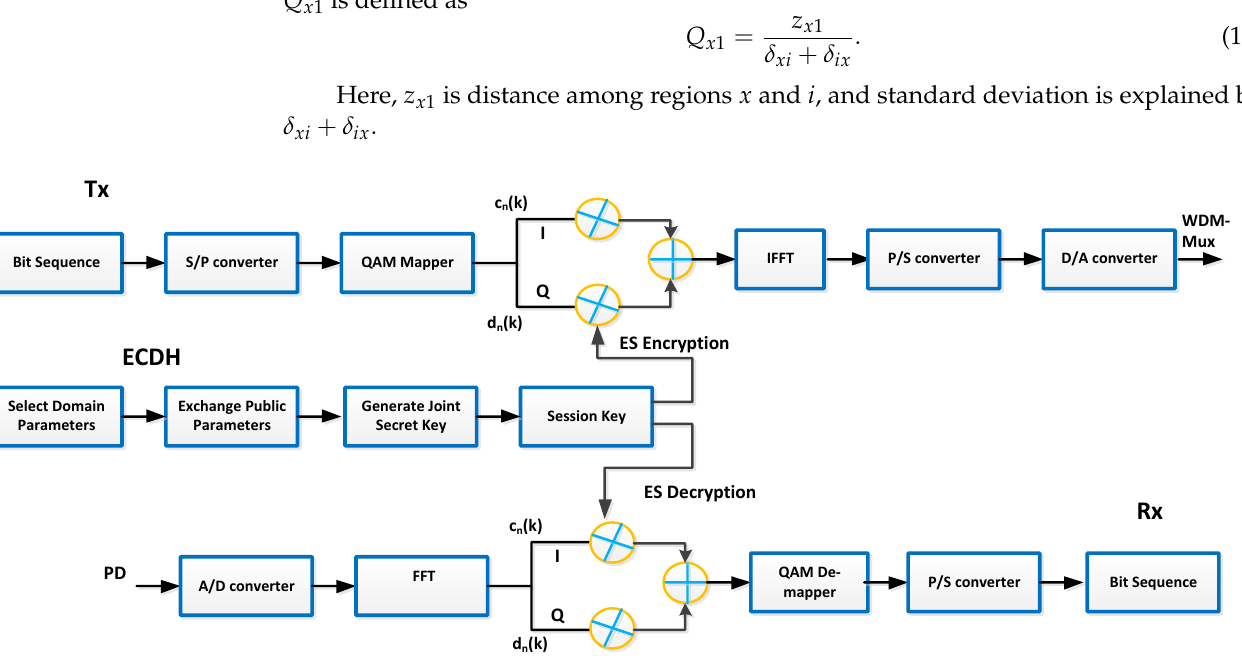
Figure 2. Architecture of ECDH-based ES algorithm used for proposed